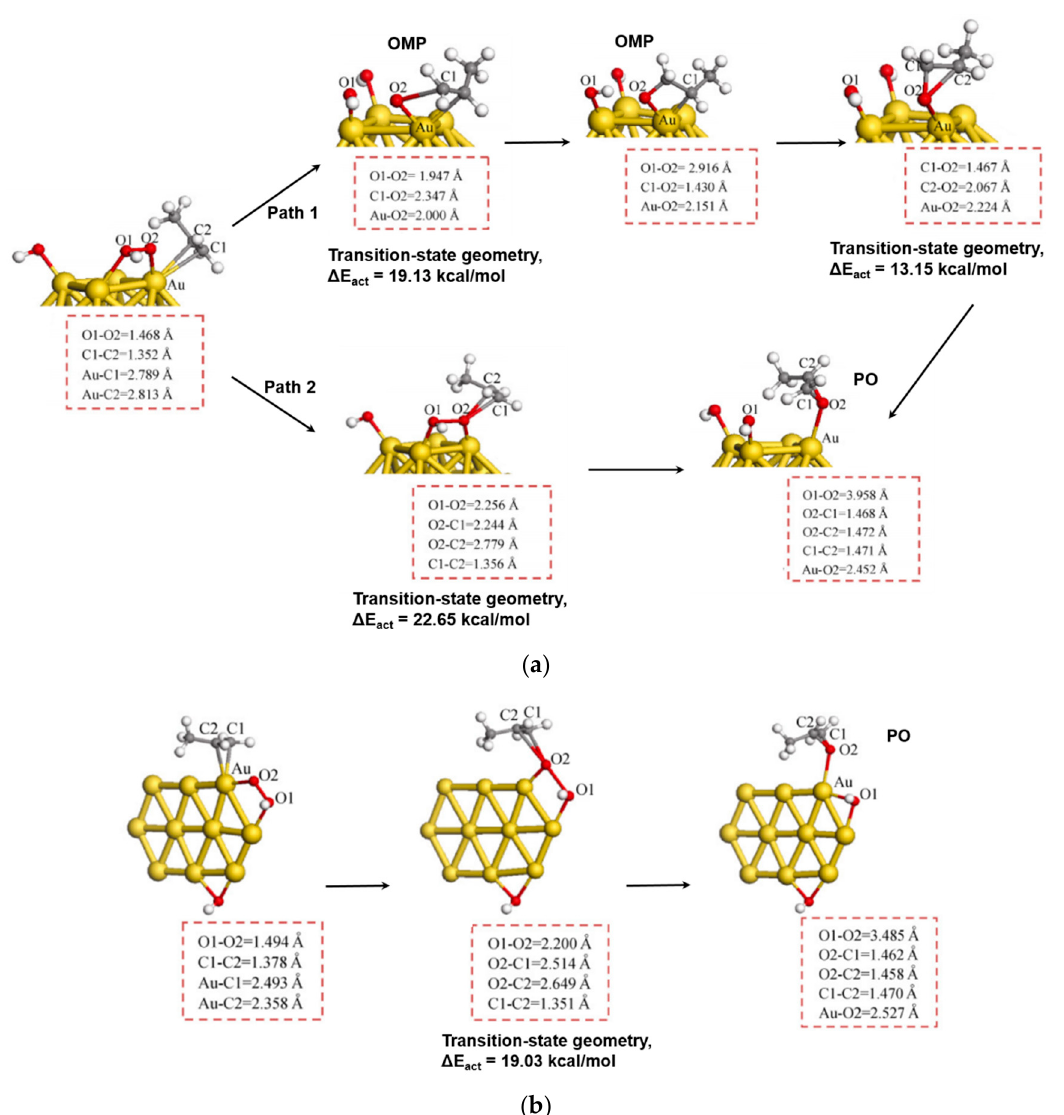
Figure 9. PO formation ( a ) on Au 38 cluster where two different pathways are shown with their corresponding transition-state geometries and activation energies; ( b ) on an Au 10 cluster where only one path is possible, along with the corresponding transition-state geometry and activation energy [130]. Copyright © 2011 Elsevier B.V.